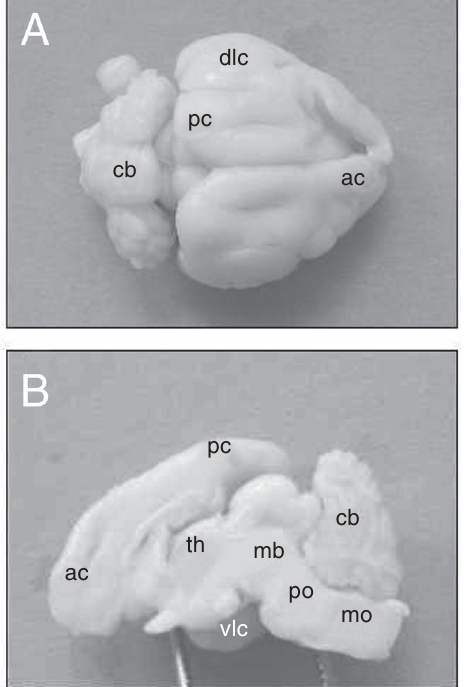
Figure 1. Rabbit brain showing the sections examined by nested PCR for the presence of latent bovine herpesvirus type 1 and 5 DNA. A , Dorsal view; B , sagittal view. cb = cerebellum; pc = pos- terior cerebral cortex; dlc = dor- solateral cerebral cortex; ac = anterior cerebral cortex; th = thalamus; mb = midbrain; vlc = ventrolateral cerebral cortex; po = pons-medulla; mo = medulla oblongata. Olfactory bulb (ol) and trigeminal ganglia (tg) are not shown.